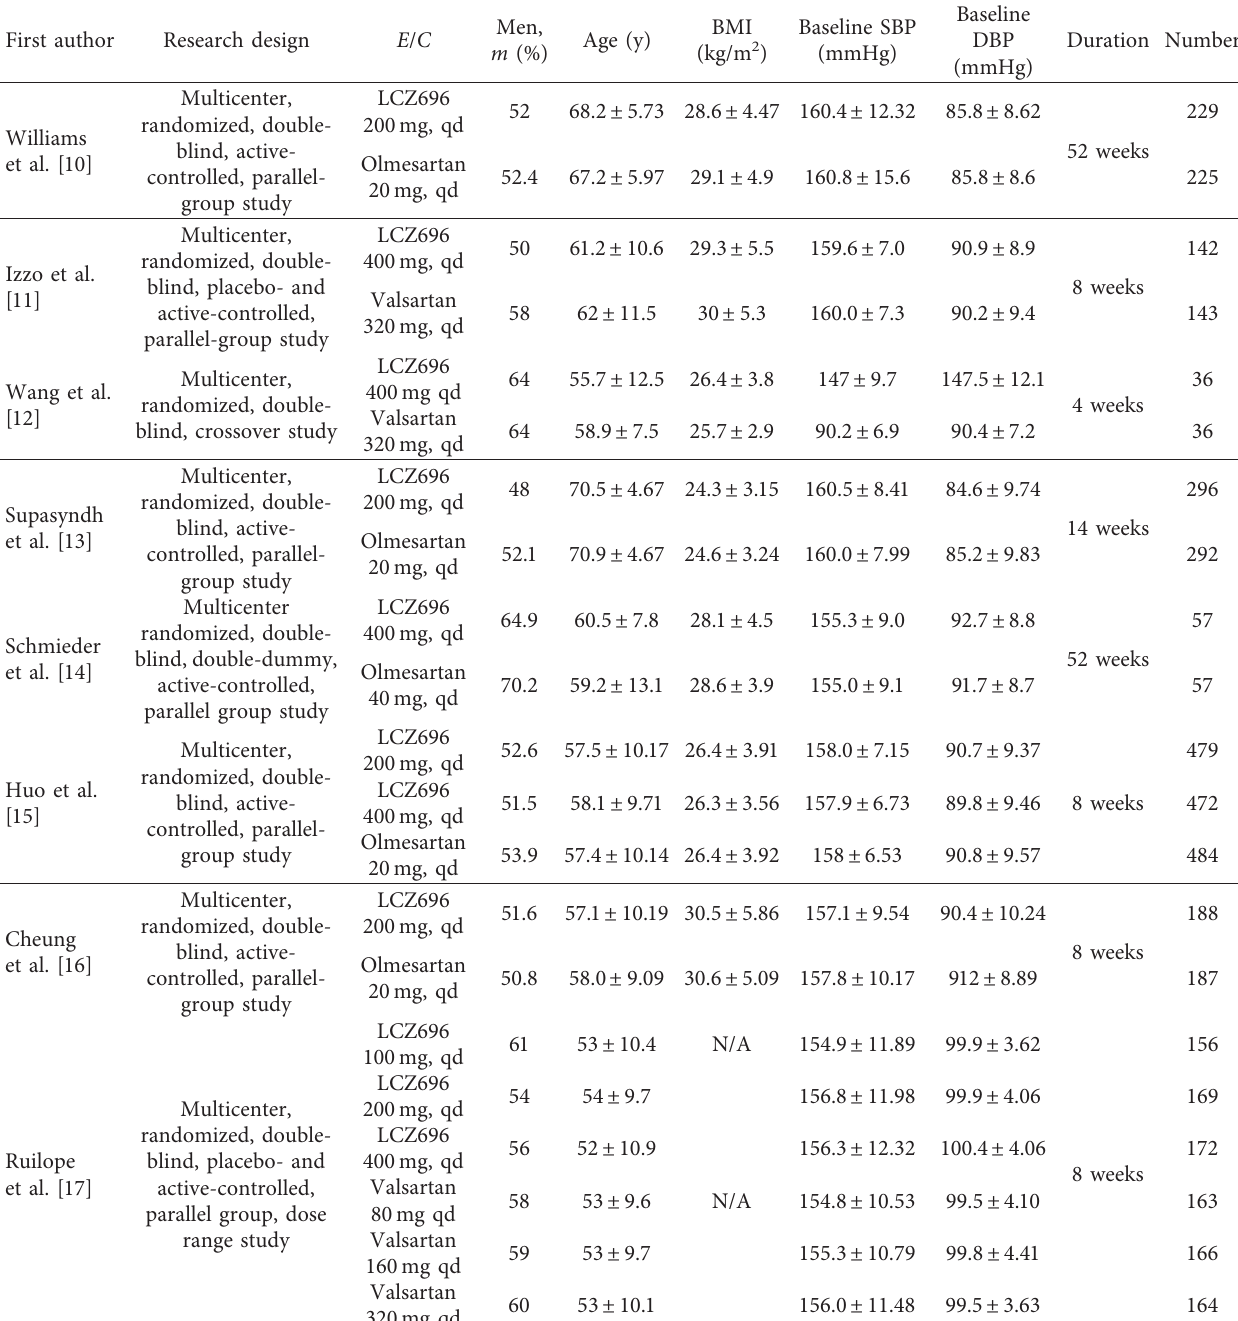
Table 1: Baseline characteristics of studies incorporated in the